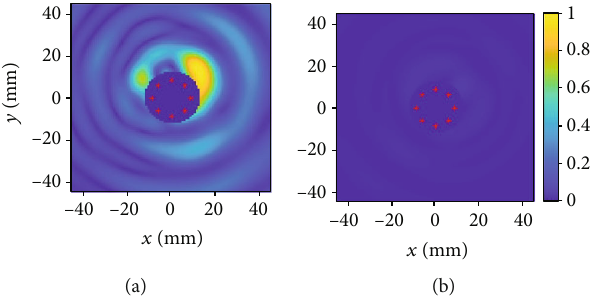
Figure 4: Image frames obtained with microwave-based colonoscopy. The dark blue circle in the middle of the plot indicates the position of the acquisition device, and the red dots the position of each antenna. (a) The highest intensity yellow spot indicates the presence of the polyp. (b) The colors are uniform showing that there are no lesions in the mucosa.